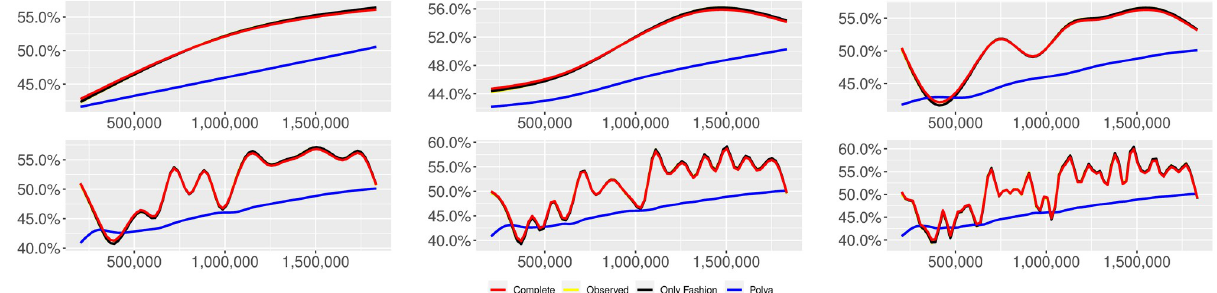
Fig 23. “Covid” ( T = 0.35, entire, D = 3 0 , slots = days): Sentiment curves. In each panel, the yellow line is the cubic spline smoothing of the time series of the observed tweets ξ , together with the default confidence interval (gray), the red line represents the cubic spline smoothing of the time series of n +1 the estimated predictive means ^ c (defined in Subsec. 3.2), obtained with the complete RP model, the black and the blue lines provide similar n approximations obtained with the other models: black = Only fashion RP model and blue = Standard Po´lya model. In each panel, the smoothing is obtained with a given number of nodes: k = 3 (top left panel), 5 (top middle panel), 10 (top right panel), 20 (bottom left panel), 30 (bottom middle panel), 50 (bottom right panel).